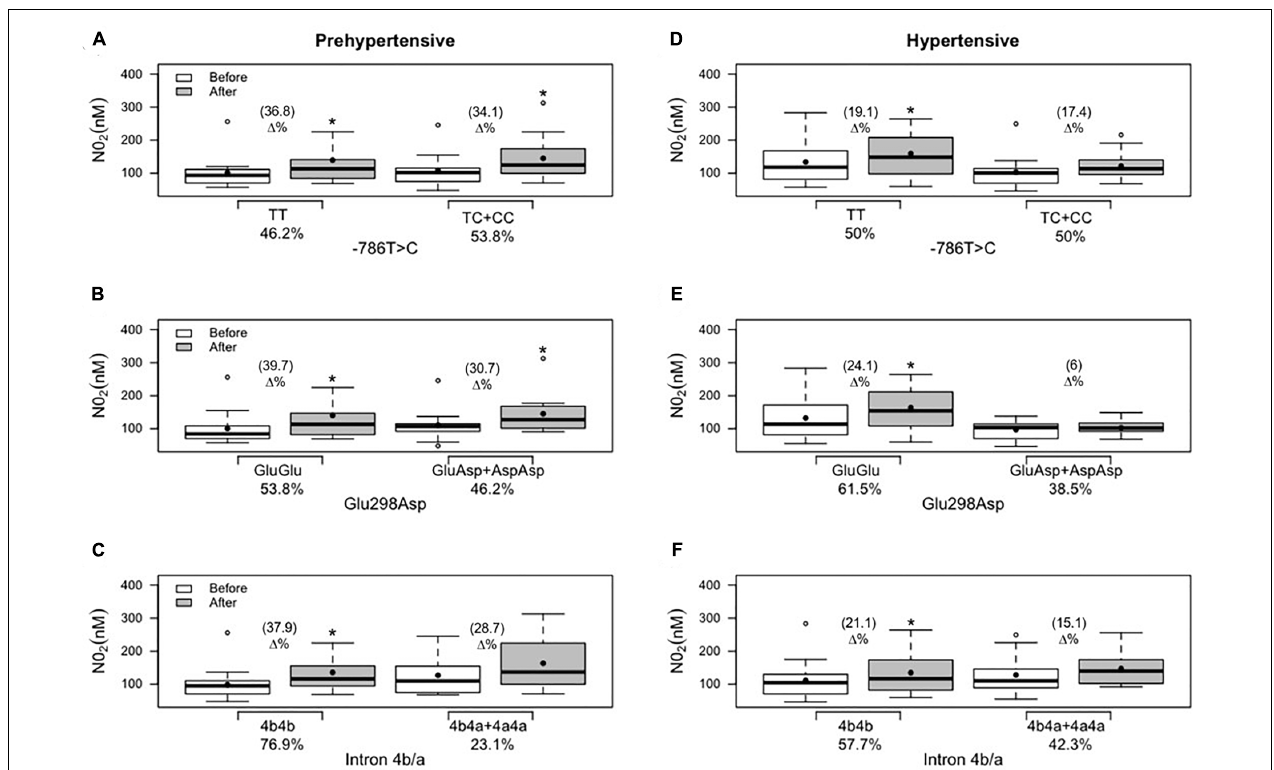
FIGURE 4 | Effects of 12 weeks of multicomponent training on nitrite concentration (NO 2 ) of 26 prehypertensive and 26 hypertensive older adult women with or without the variant genotypes for the NOS3 gene at positions –786T > C, 894G > T (Glu298Asp), and intron 4b/a. * p < 0.05 compared with the before intervention (the same group). (A) Genotypes for the NOS3 gene at position − 786T > C in the prehypertensive group. (B) Genotypes for the NOS3 gene at position 894G > T (Glu298Asp) in the prehypertensive group. (C) Genotypes for the NOS3 gene at intron 4b/a in the prehypertensive group. (D) Genotypes for the NOS3 gene at position − 786T > C in the hypertensive group. (E) Genotypes for the NOS3 gene at position 894G > T (Glu298Asp) in the hypertensive group. (F) Genotypes for the NOS3 gene at intron 4b/a in the hypertensive group. Linear mixed-effects